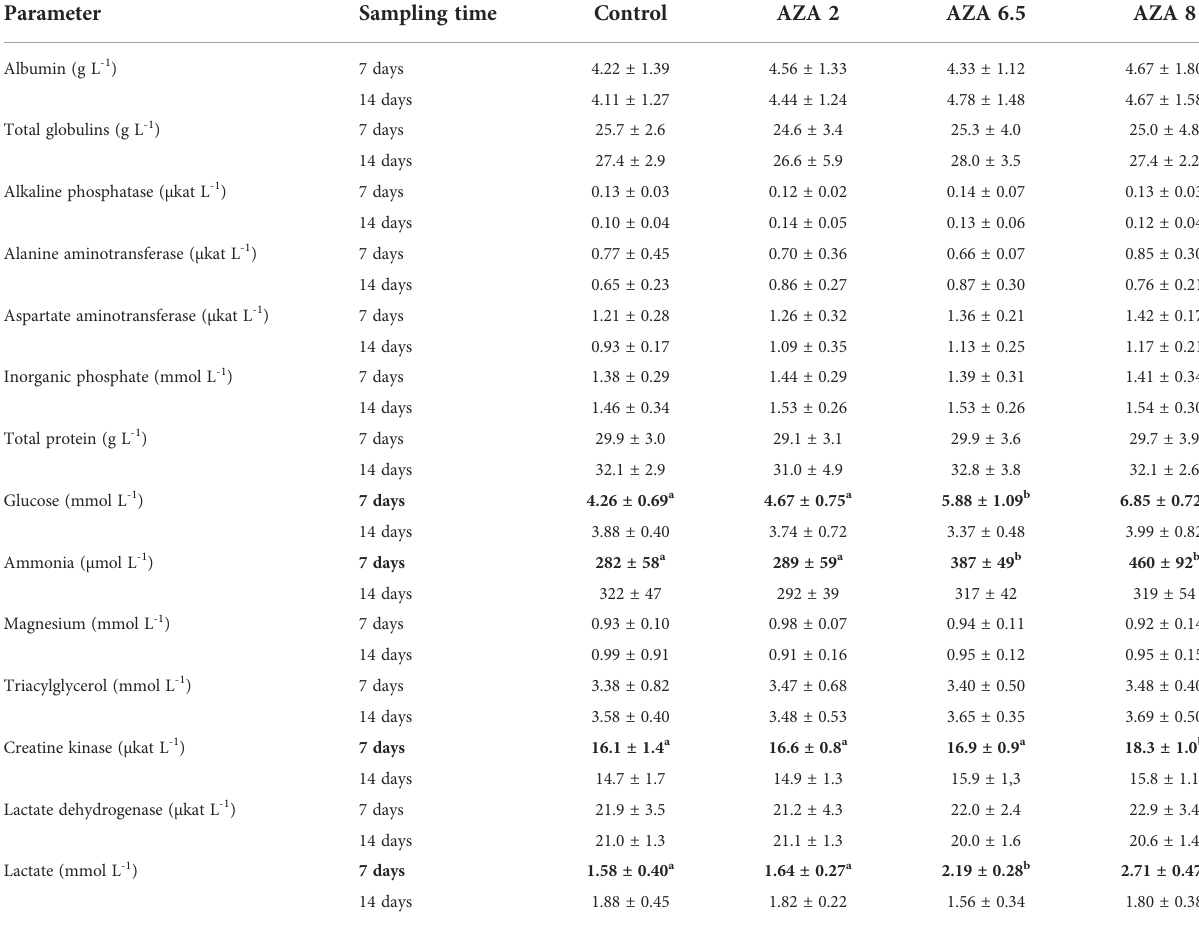
TABLE 4 Blood biochemistry values (mean ± SD) measured from the blood of Nile tilapia kept in control and exposed to different concentrations of azadirachtin (AZA 2 µg L -1 ; AZA 6.5 µg L -1 and AZA 8 µg L -1 ) for 7 days and after recovery period (14 days).